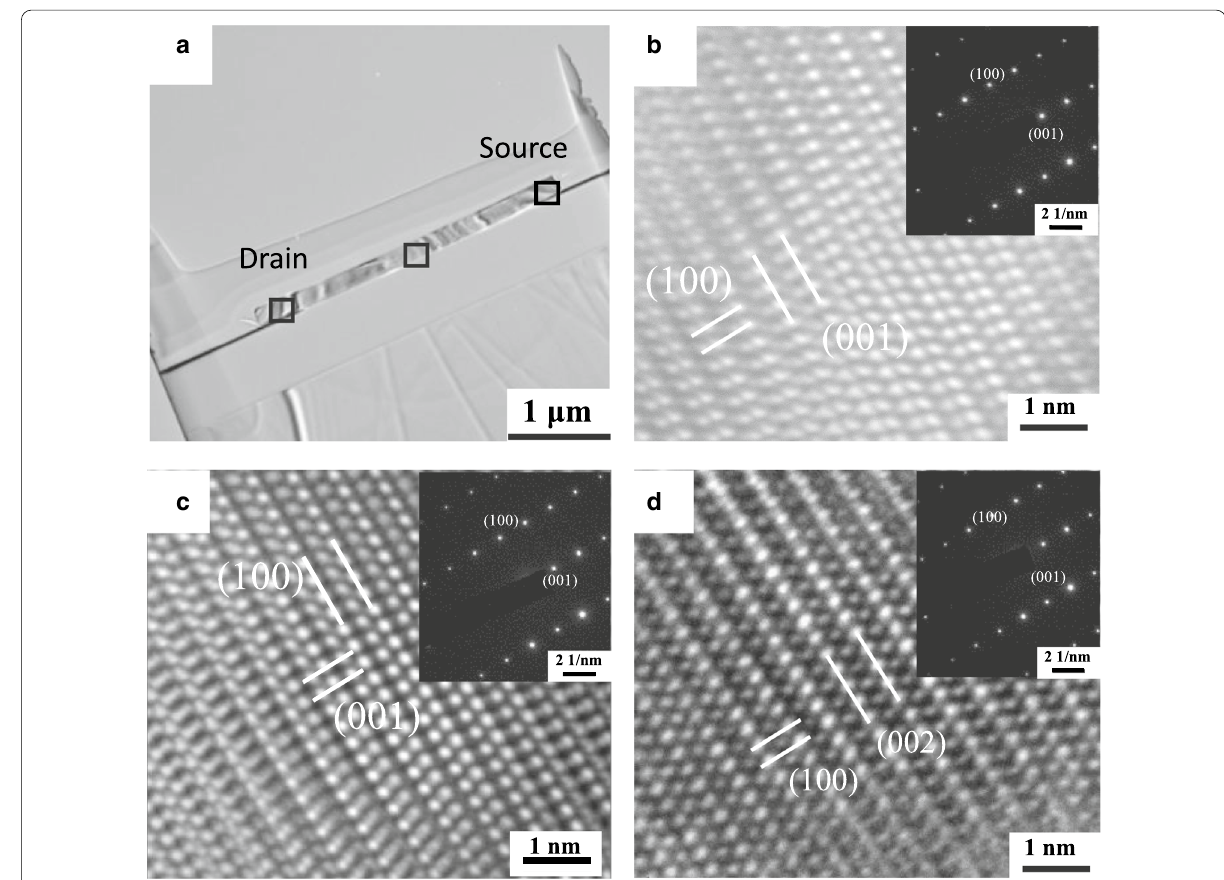
Fig. 5 a TEM images of the individual ZnO NW device that was fabricated using a voltage of 3 V in the alignment process and exhibited a rectifying IV characteristic. The atomic TEM image of the drain side of ZnO NW and the area corresponds to the left square in a . The atomic TEM image of the middle of ZnO NW and the area corresponds to the middle square in a . The atomic TEM image of the source side of ZnO NW and the area corresponds to the right square in